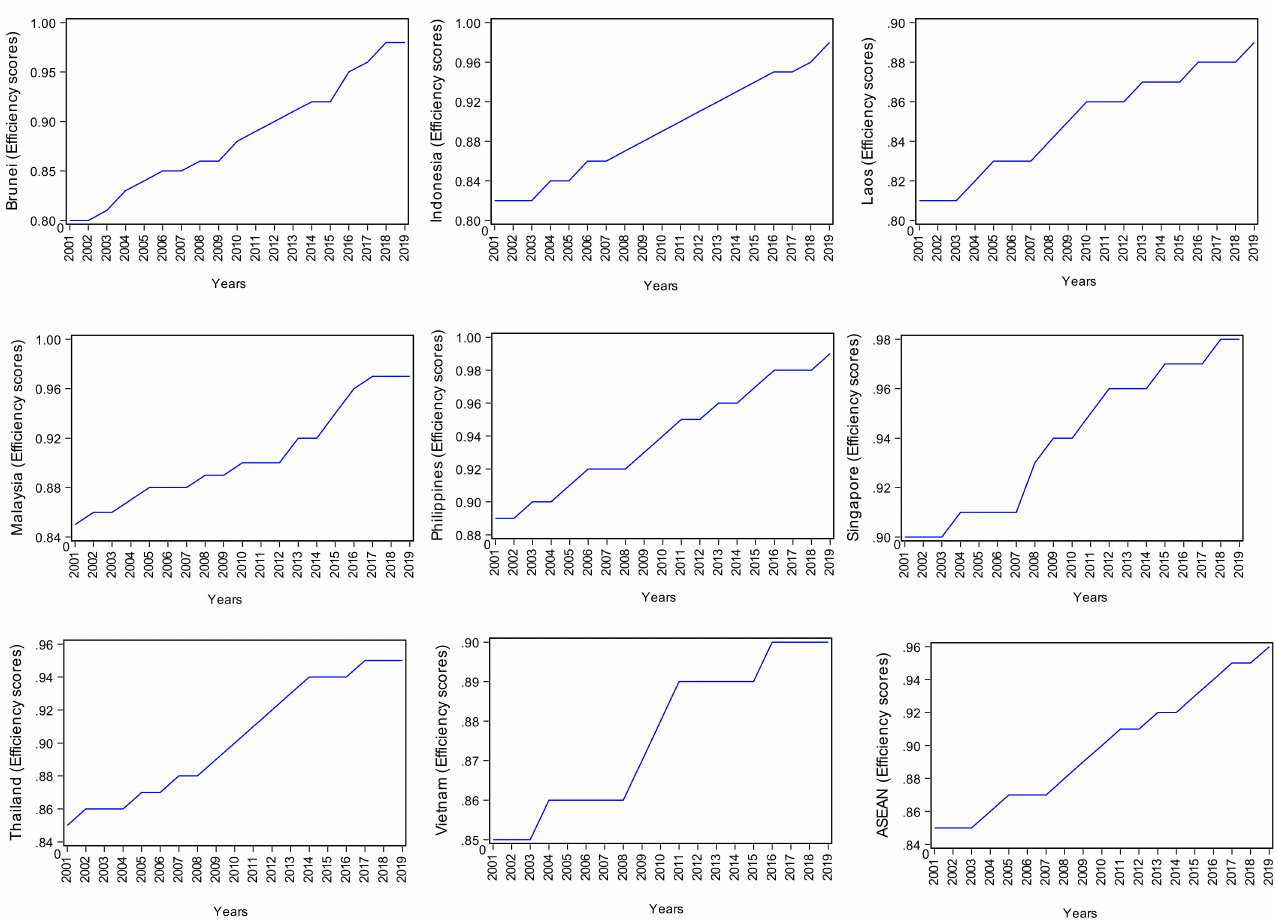
Figure 1. The trend of energy efficiency in ASEAN countries.